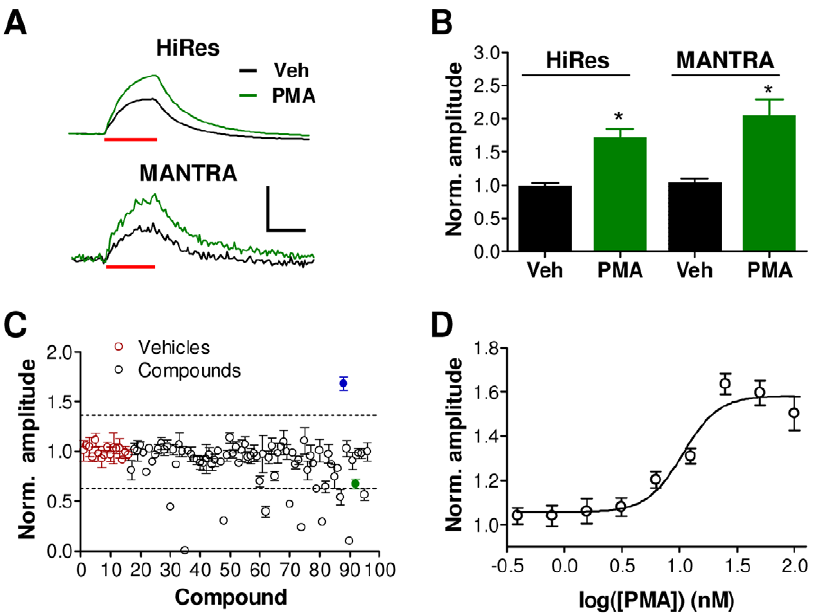
Figure 5. The MANTRA system can detect modulators of synaptic vesicle cycling. ( A ) SypHy traces from neuronal cultures treated with PMA (1 m M) or vehicle (0.7% DMSO) generated with the high resolution microscope system (HiRes) or the MANTRA system in response to a 5 Hz, 30 sec stimulus train. Scale bar: 0.1 D F/F, 20 sec. ( B ) Vehicle-normalized amplitudes (mean 6 SEM) in response to the 5 Hz, 30 sec stimulus train in vehicle- and PMA-treated cultures measured on the microscope based system (HiRes; n=3) and on the MANTRA system, for which statistics were generated from three randomly selected PMA- and vehicle-treated replicates. ( C ) The plate of the LOPAC library containing PMA was screened in triplicate on the MANTRA system (10 m M; 1 hour incubation) using a stimulation protocol consisting of a 5 Hz, 30 sec train, a 10 Hz, 30 sec train, and a 30 Hz, 15 sec train with stimulation trains separated by 5 minute intervals. Shown are the amplitudes (mean 6 SEM) of the three replicates for each compound normalized to the mean amplitude of the vehicle wells. Dotted lines indicate three standard deviations from the vehicle mean. Red points indicate vehicle wells, blue point indicates PMA. Green point indicates N6-phenyladenosine as further described in Figure 6. ( D ) PMA concentration- response curve for response amplitudes to the 5 Hz train generated from a single plate. Each point shows the mean 6 SEM of 8 wells normalized to within-plate vehicle controls. Data were fit with a standard sigmoid concentration-response function (R 2 =0.95).